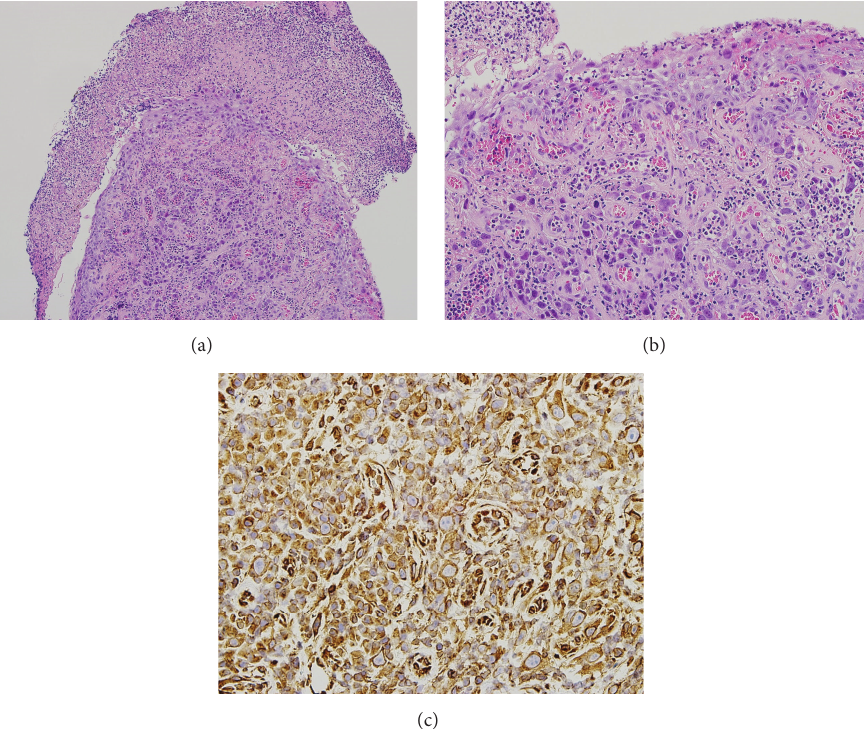
Figure 2: Light microscopic findings. ((a) and (b)) Bizarre stromal cells with large, hyperchromatic, atypical nuclei containing prominent nucleoli are observed using hematoxylin and eosin (HE). (c) The atypical cells were immunopositive for vimentin. (a) Original magnification 100x, (b) original magnification 400x, and (c) original magnification